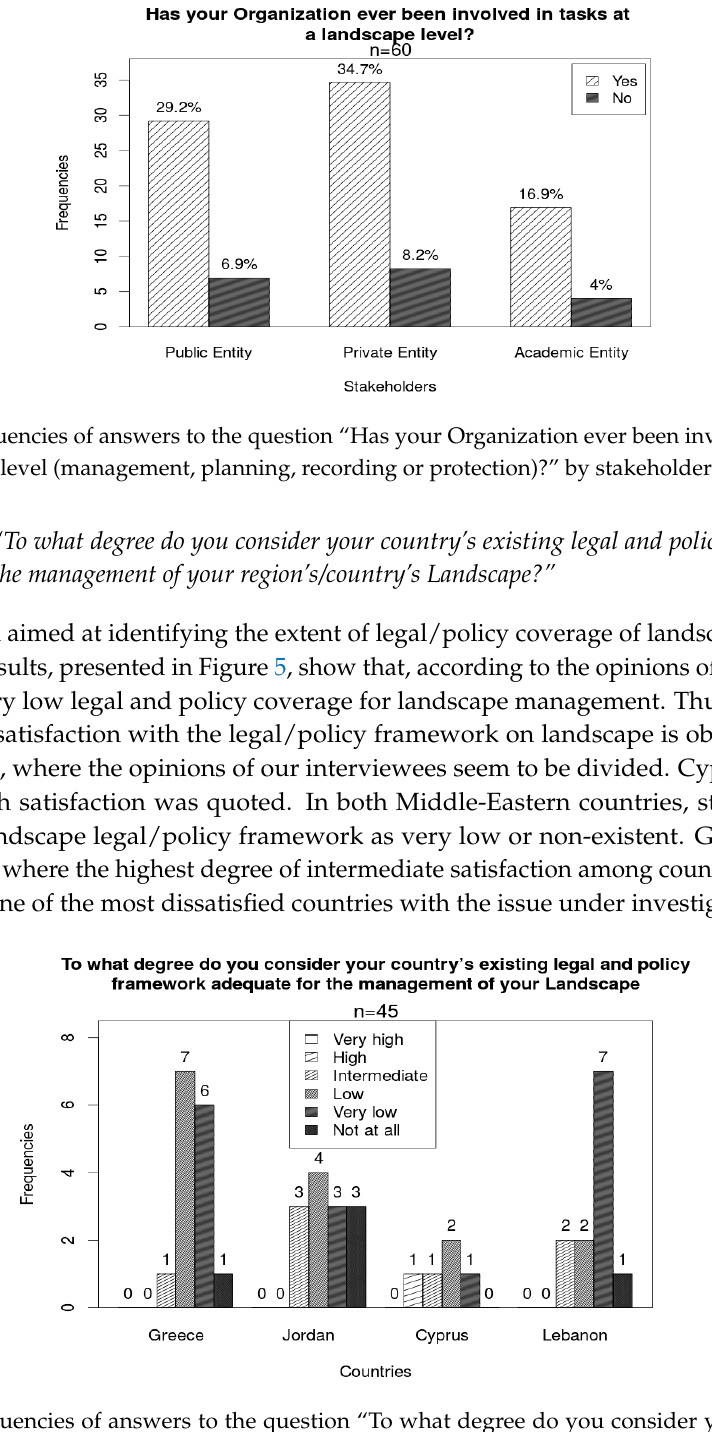
Figure 3. Frequencies of answers to the question “Has your Organization ever been involved in tasks at a landscape level (management, planning, recording or protection)?” by country of residence.